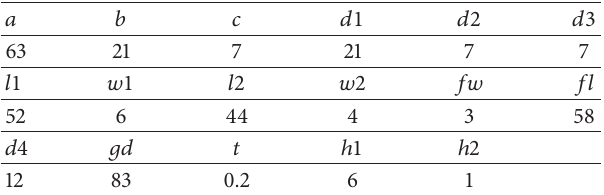
Table 1: The values of all the parameters used in Figure 1